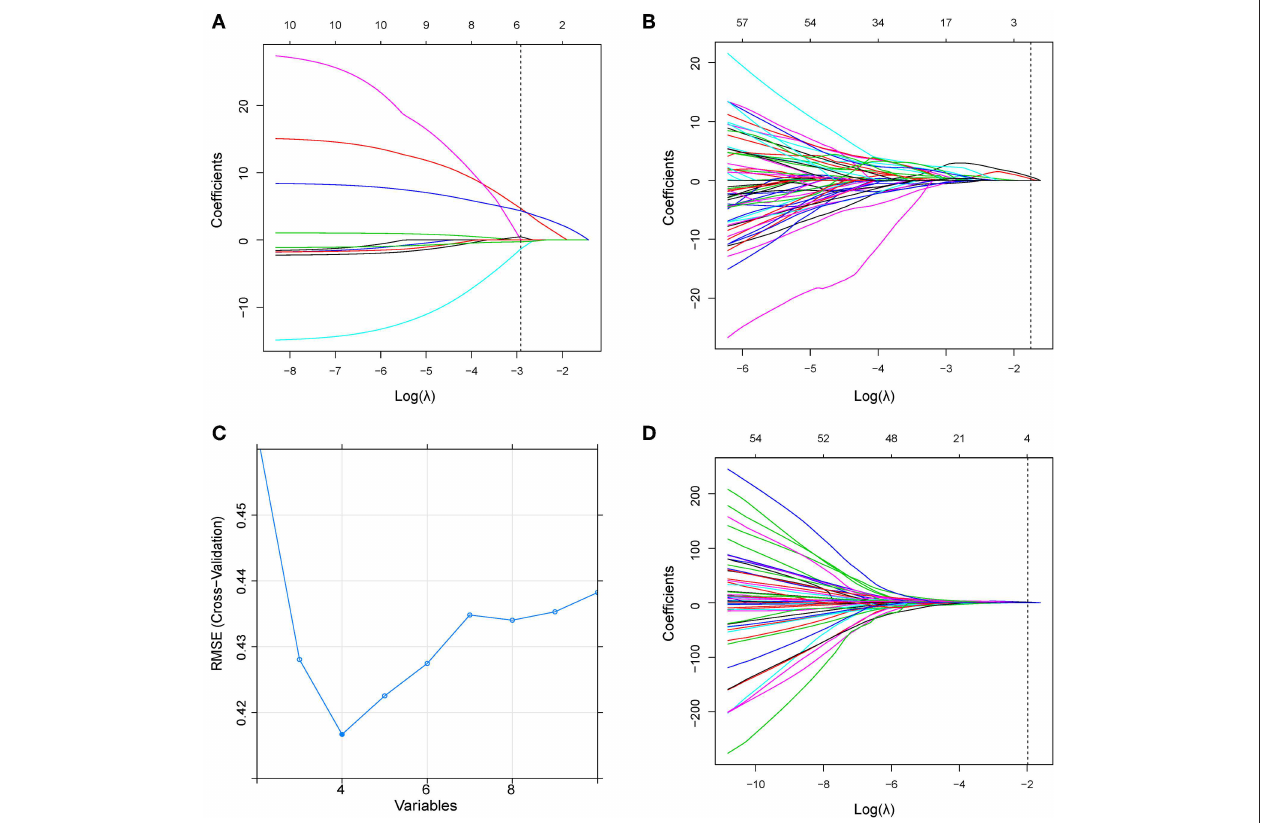
FIGURE 3 | (A) LASSO coefficient profiles of the clinical parameters in Model C . According to the 1 standard error of the minimum criteria (the 1-SE criteria), the dotted line was plotted at the selected log( λ ) ( − 2.914) via 10-fold cross-validation. (B) LASSO coefficient profiles of the radiomic features in Model R . A log( λ ) value of − 1.750 was chosen (10-fold cross-validation, 1-SE criteria). (C) Feature selection using the RFE method in Model CR1 . The rank of feature importance was obtained using the random forest method; RFE built the model continuously by eliminating the lower ranking feature. The RMSE was used to select the optimal feature set in a 10-fold cross-validation. (D) LASSO coefficient profiles of the combined feature set in Model CR2 . A log( λ ) value of − 1.983 was chosen (10-fold cross-validation, 1-SE criteria). RFE, recursive feature elimination; RMSE, root mean square